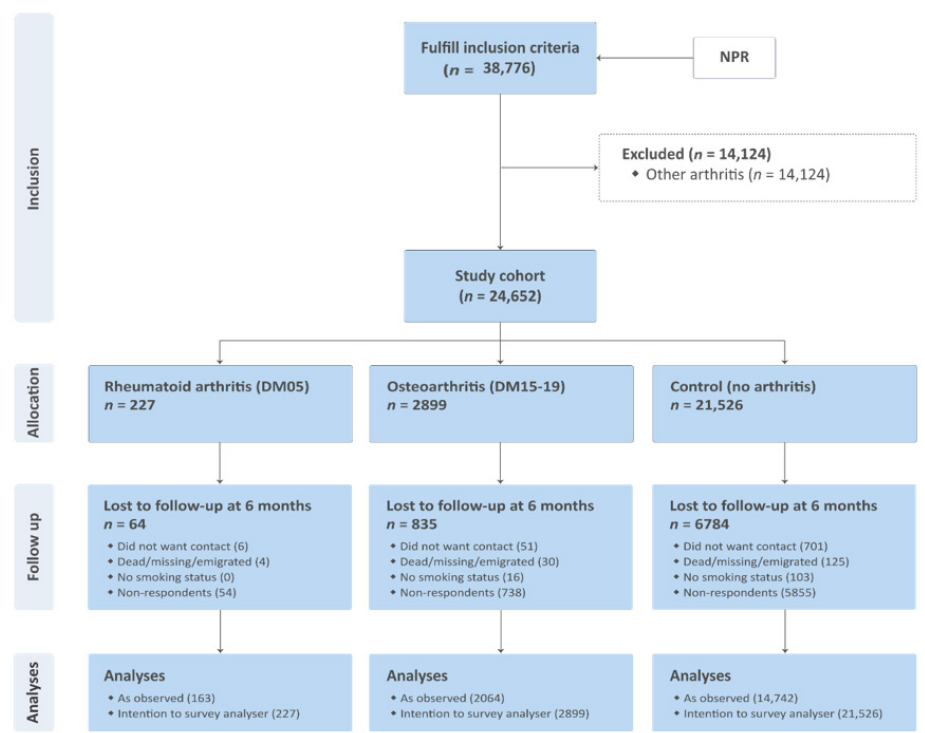
Figure 1. Flowchart for inclusion, allocation, follow up, and analysis. Allocation groups are based on ICD-10 codes, International Classification of Diseases, 10th edition [21]; RA, seropositive rheumatoid arthritis; OA, osteoarthritis. NPR: National Patient Register. A diagnosis was identified of RA in 227 (1%) and OA in 2899 (12%) patients of the total study cohort (Figure 1). The characteristics of the groups are presented in Table 1. The groups were considered different, if the dissimilarity was greater than five percentage points compared to the control group. This was the case for both RA and OA regarding age, disadvantaged smokers, heavy smoking, being recommended by health staff, getting free NRT or other supportive medicine, and programme format. In addition, RA differed from the control group regarding sex and living with a smoker. Table 1. Characteristics of the participants in the study cohort according to arthritis diagnosis: RA, OA, and control (no arthritis) at baseline.